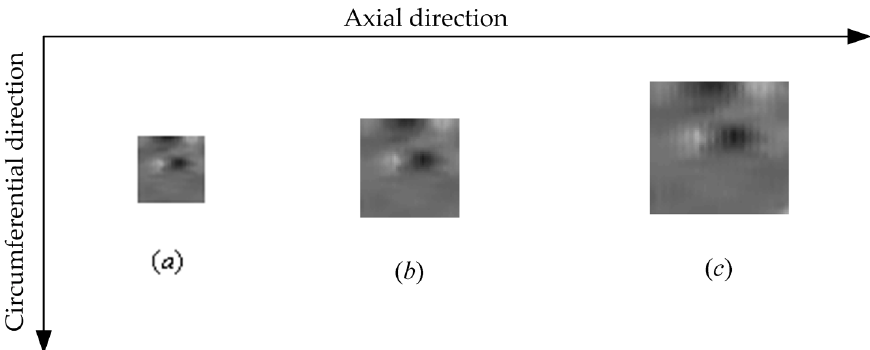
Figure 12. Different resolution reconstruction results: ( a ) double resolution reconstruction image; ( b ) triple resolution reconstruction image; ( c ) quadruple resolution reconstruction image.